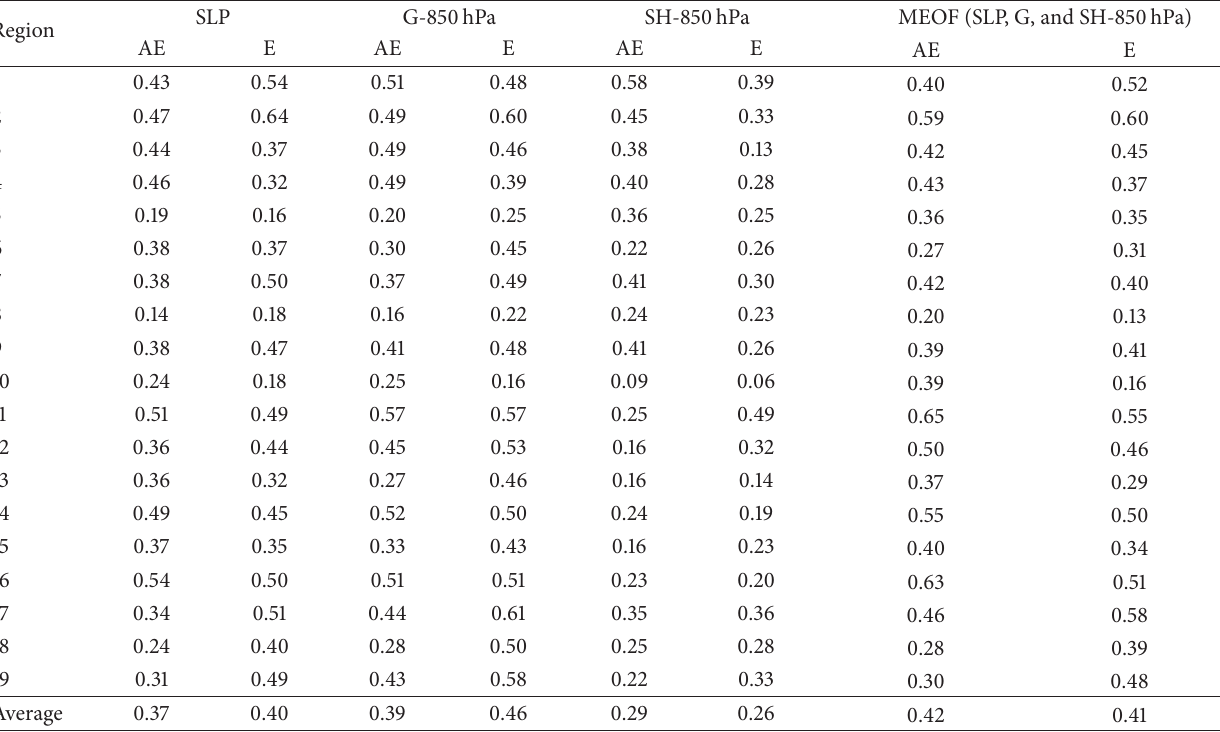
Table 2: Correlation coefficients between observed and simulated precipitation by NHMM taking into account atmospheric predictors (first 10 PCs) over the Atlantic European (AE) and the European (E) regions. MEOF here represent a combination between SLP, geopotential at 850 hPa, and specific humidity at 850